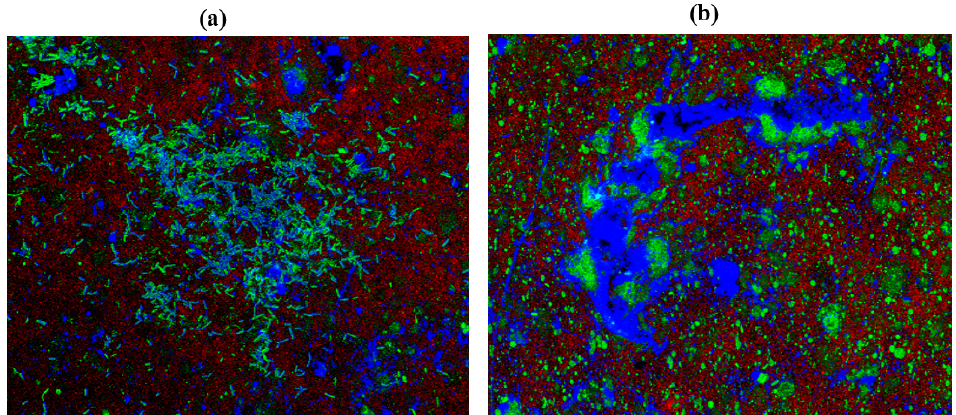
Figure 6. 3D resolution images of C. albicans M207 control using CLSM at ( a ) 12 h; ( b ) 24 h. All images were captured at 40× magnification under oil immersion.